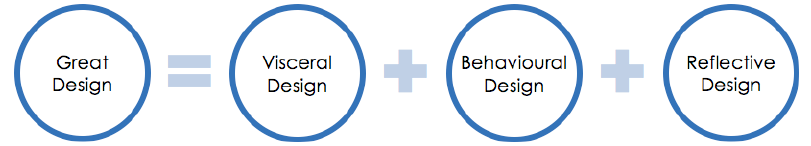
Figure 3. Components of great design based on Donald Norman’s book